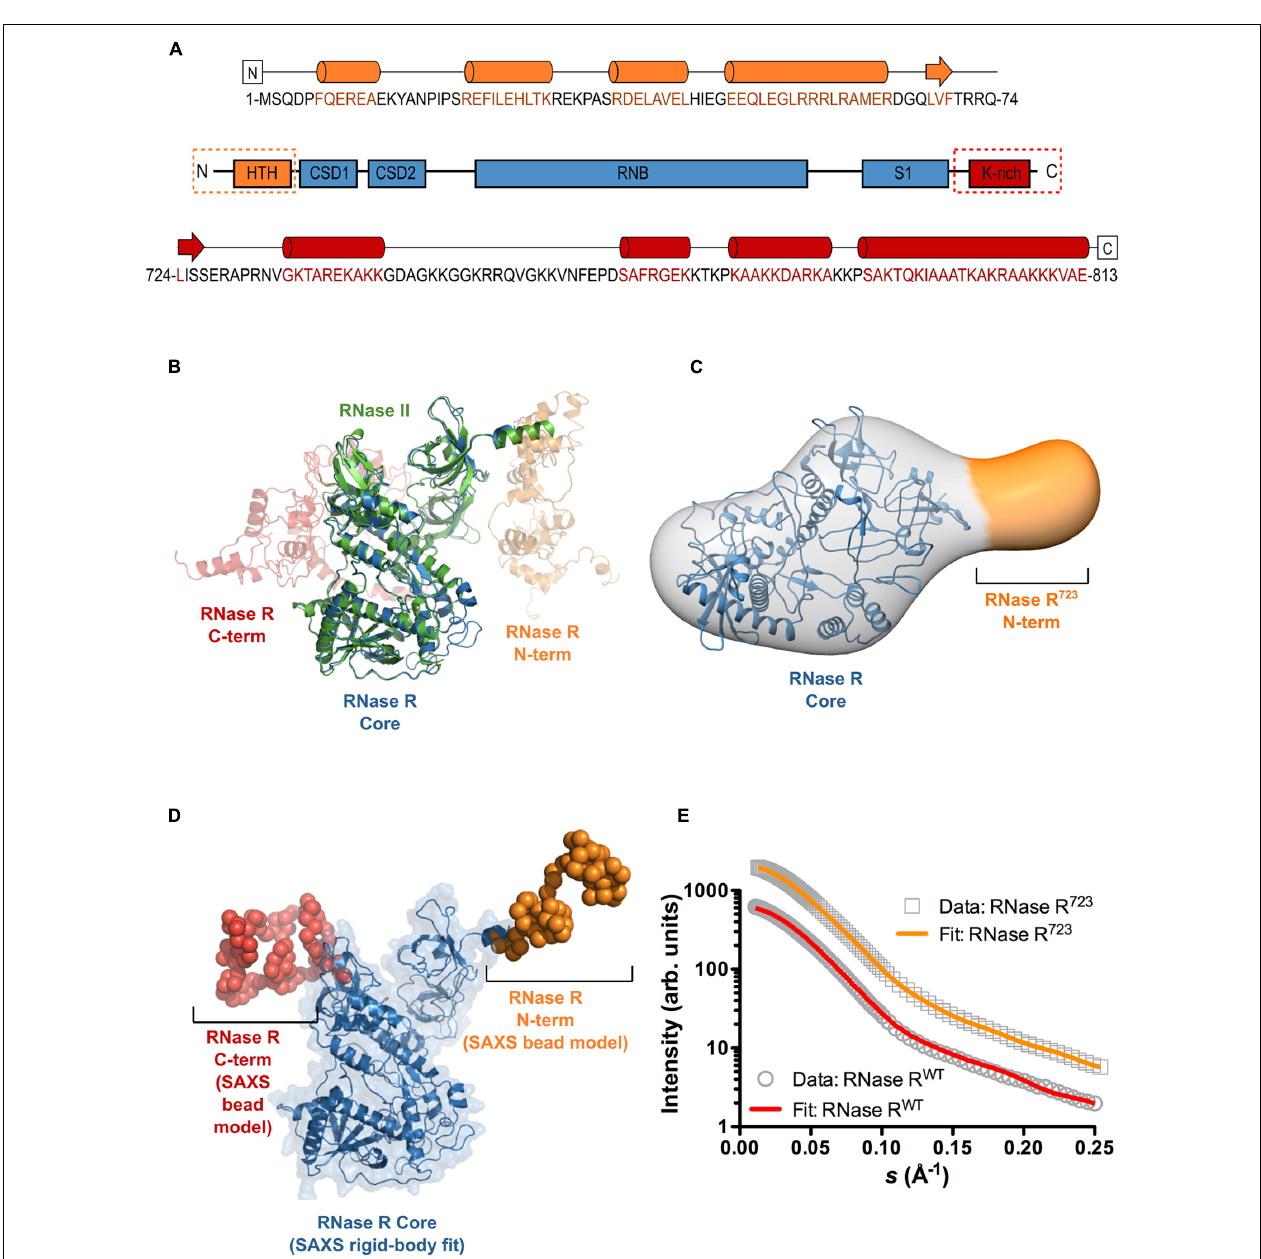
FIGURE 1 |The overall shape and relative domain orientation of full-length RNase R. (A) Secondary structure prediction from I-TASSER for the N-terminal domain (orange), the catalytic core (blue), and the C-terminal domain (red) of RNase R. Predicated helical regions are shown as cylinders, β -strands as arrows, and random coil regions as black lines. (B) Superposition of the crystal structure of RNase II (PDB ID 2ID0) and the three top-scoring homology models of full-length RNase R generated with I-TASSER. RNase II is shown as a green cartoon, the conserved core of RNase R is shown as a blue cartoon. (C) SAXS envelope showing the 3D molecular shape of RNase R 723 . The I-TASSER model of the conserved core domain (shown in panel B ) has been docked into the SAXS envelope using SITUS, with a resulting correlation coefficient of 0.88. The additional density seen in the SAXS envelope (indicated in orange) corresponds to residues 1–65 of RNase R 723 . The C-terminal residue in the I-TASSER model of the core domain is indicated with an asterisk. (D) SAXS model of